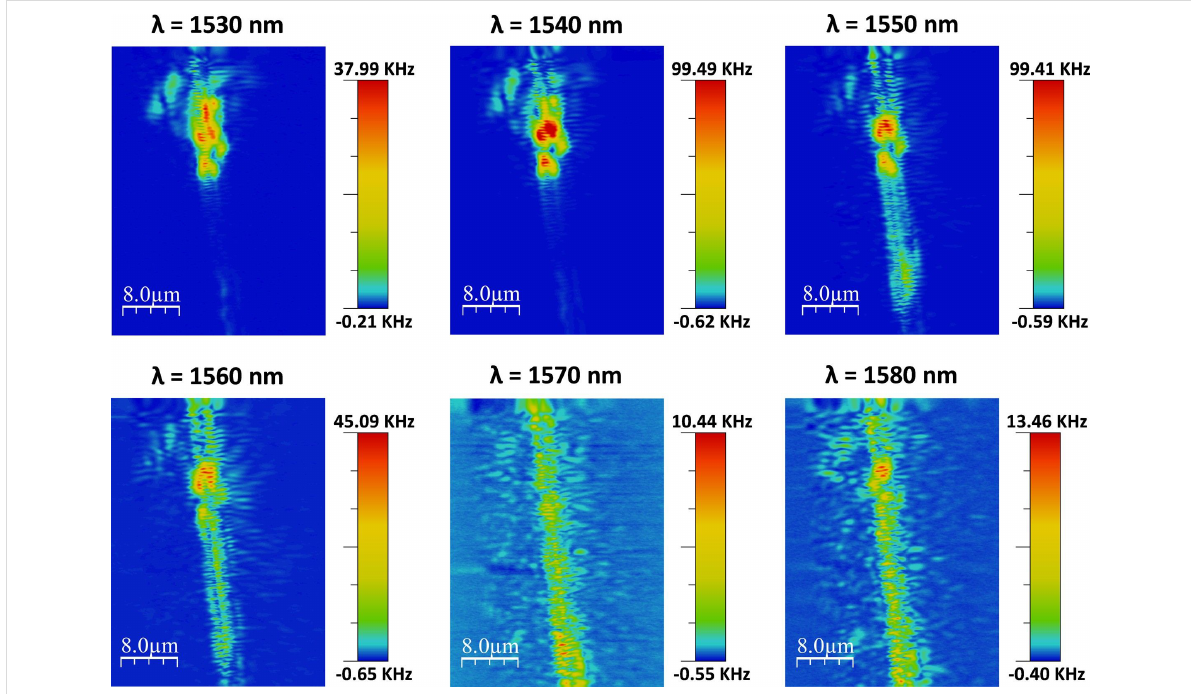
Figure 3: SNOM measurements obtained at different wavelengths (from 1530 to 1580 nm) for one of the PBG sensing structures having transversal elements of width w i = 120 nm. The measurements are carried out at 20 nm from the surface of the PBG